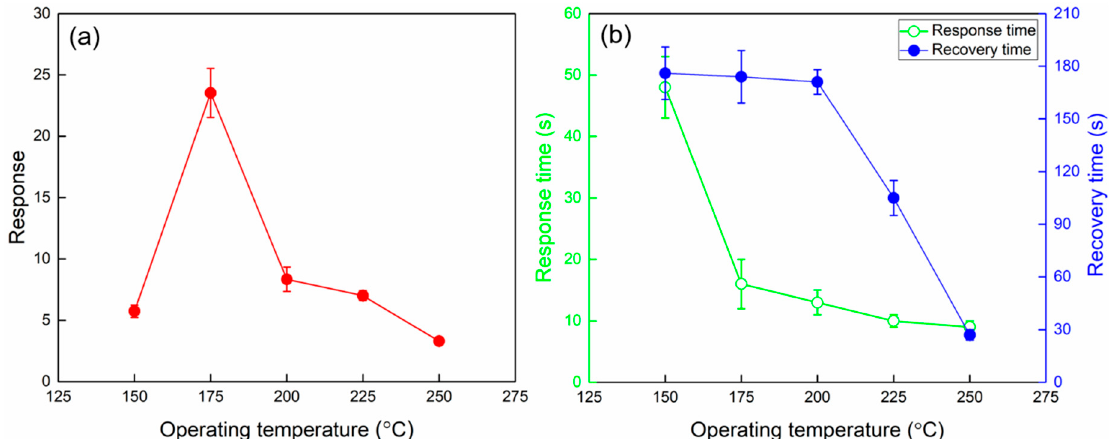
Figure 8. ( a ) Response and ( b ) response and recovery times of 1% Zn-doped α -Fe 2 O 3 nanowires upon exposure to 5 ppm H 2 S at different operating temperatures.